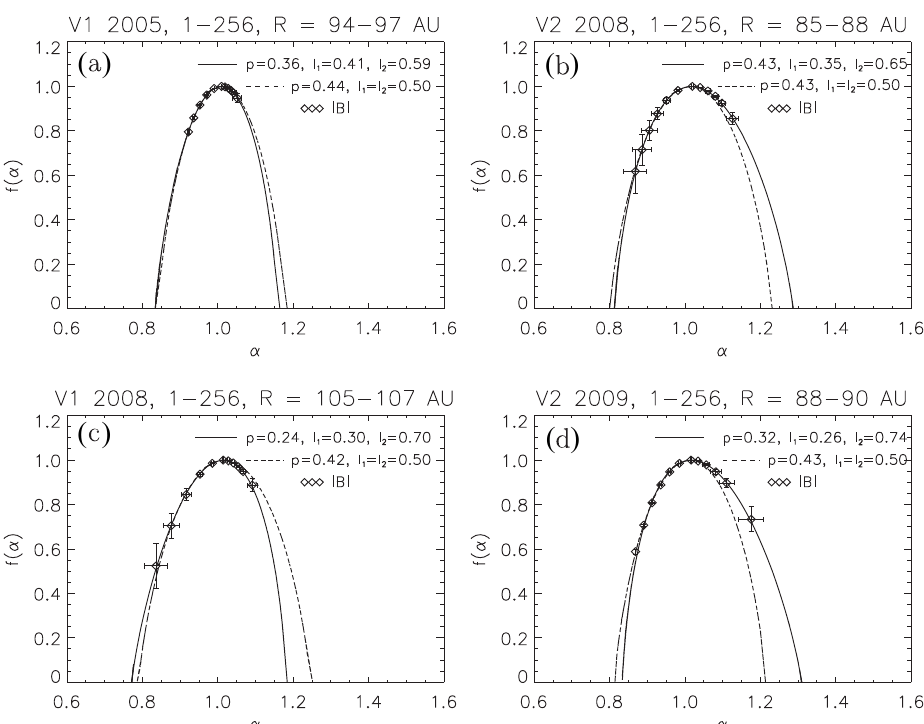
Figure 4. The singularity spectrum f (α) as a function of a singularity strength α . The values are calculated for the weighted two-scale (continuous lines) model and the usual one-scale (dashed lines) p model with the parameters fitted using the magnetic fields (diamonds) measured by Voyager 1 in the heliosheath at various heliocentric distances of (a) 94–97AU and (c) 105–107AU, and by Voyager 2 at (b) 85–88AU and (d) 88–90AU, respectively, taken from Macek et al. (2012).